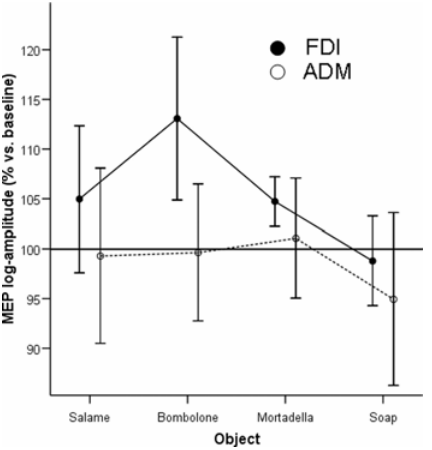
Figure 5. Results of Experiment 3. Mean percentual changes of MEP amplitude versus ‘‘ Basal ’’ in the FDI muscle, which was prime mover for the observed grasping action, and in the ADM muscle which has no functional role in grasping. Only the congruency between the odour of bombolone with the observation of grasping a bombolone, but not other food or non-food objects, produced a significant increase of MEP size, which selectively took place in the prime mover. No changes are observed in the ADM muscle. Statistics are in the